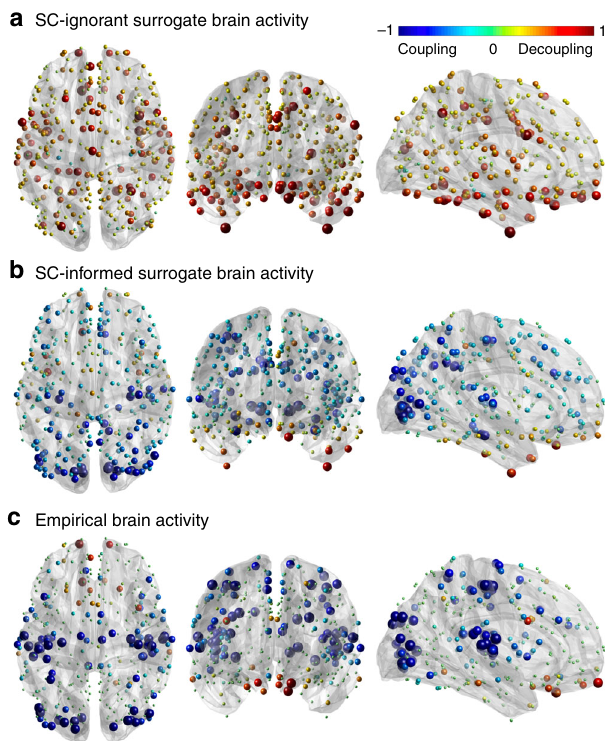
Fig. 2 Structural-decoupling index as a new measure of regional coupling between function and structure. The binary logarithm of the index is plotted here for three different brain activity signals, highlighting their coupling to the structural connectome. As the index is reported in logarithmic scale, a value of 1 indicates a double structural decoupling of a region with respect to coupling; vice versa, a value of (cid:2) 1 corresponds to a double coupling with respect to decoupling. The evaluated brain activity signals are: a surrogate connectome: as expected, their structural-decoupling index shows high courses with knowledge of the underlying structural connectome, build as a signs: the structural-decoupling index shows here a pattern of function- structure coupling purely driven by the structural graph, and, in fact, resembling the known structural core of densely interconnected and topologically central regions, mainly composed of posterior medial and parietal cortical areas 3 ; c empirical brain activity, and displaying only regions with a structural decoupling signi fi cantly different with respect to the surrogates in ( b ). Two main patterns emerge, one with regions whose functional activity signi fi cantly couples with the structural connectome, including primary sensory and motor networks (blue), the other composed of regions whose functional signals detach from the structure more than expected, including orbitofrontal, temporal, parietal areas (red).